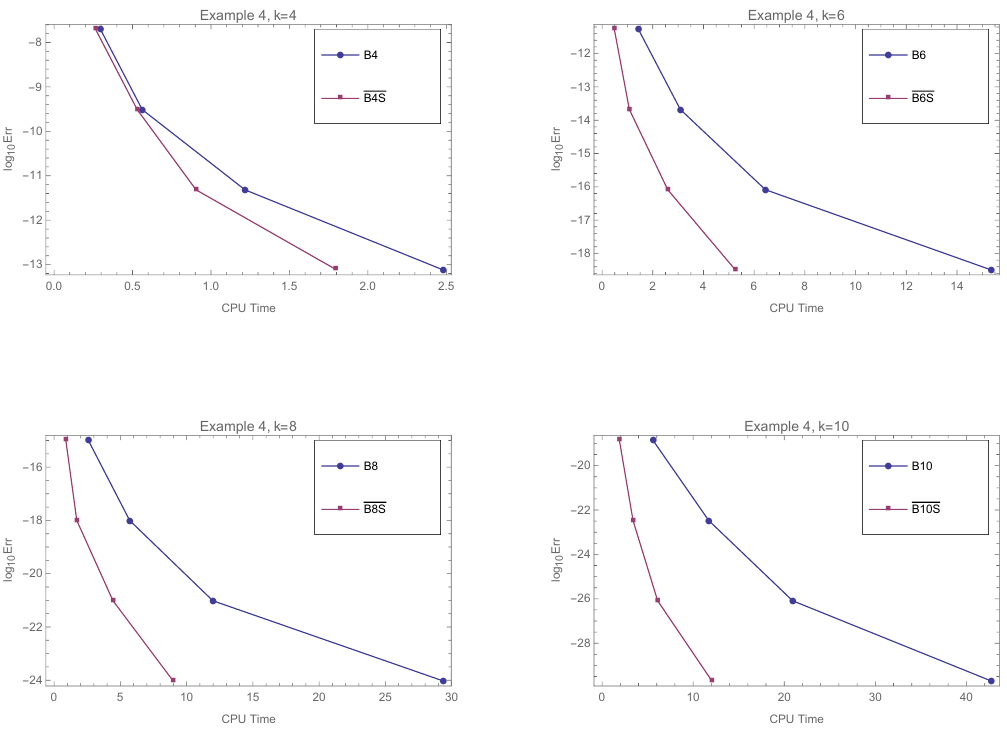
Figure 6. Efficiency curves for Example 4 comparing performances of usual formulations ( B 4, B 6, B 8, B 10) and proposed ones ( B 4 S , B 6 S , B 8 S , B 10 S